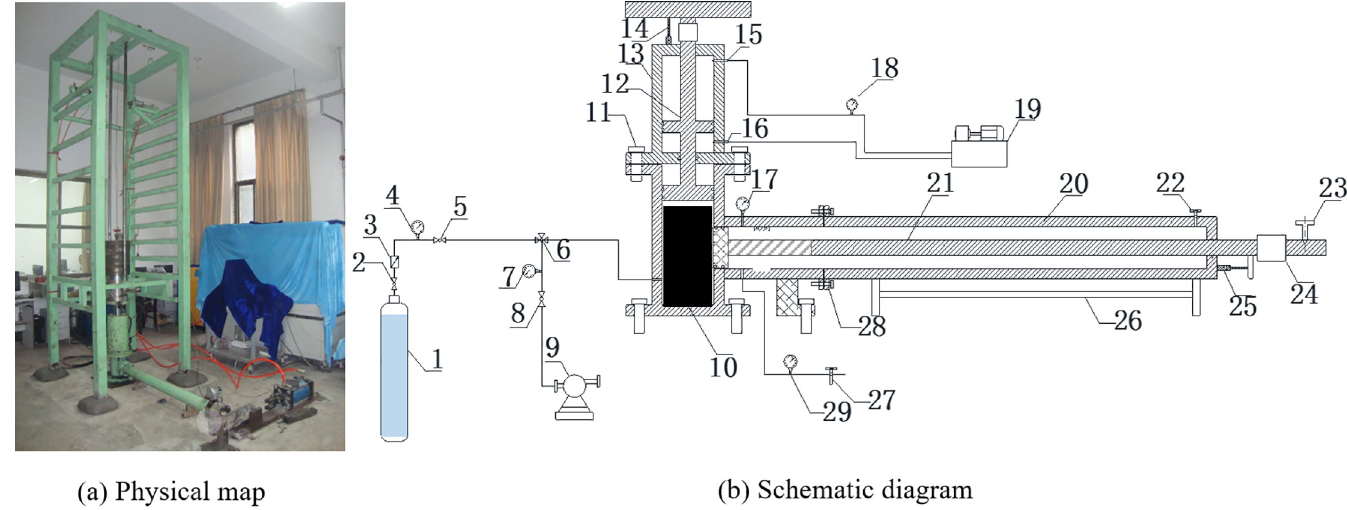
Fig 2. Spallation damage and outburst simulation experiment